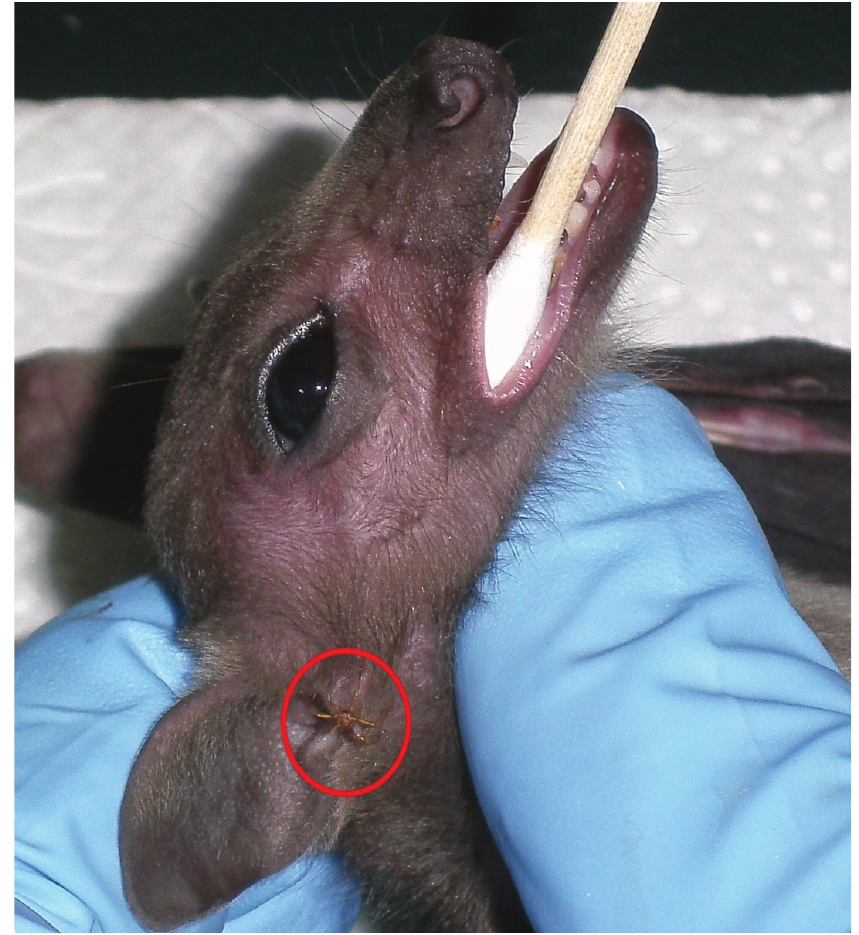
Figure 1. Bat fly (family Nycteribiidae, species Eucampsipoda africana ) at the ear lobe of an Egyptian fruit bat undergoing sampling. The fly is indicated by the red circle.